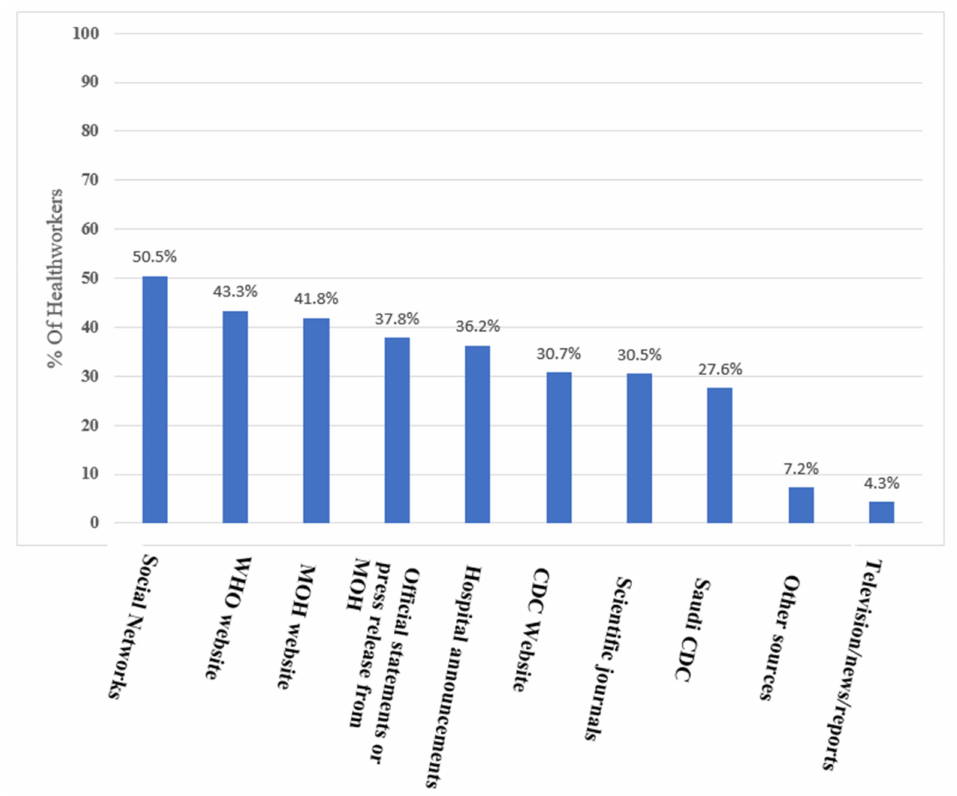
Figure 1. Health workers’ sources of Delta COVID-19